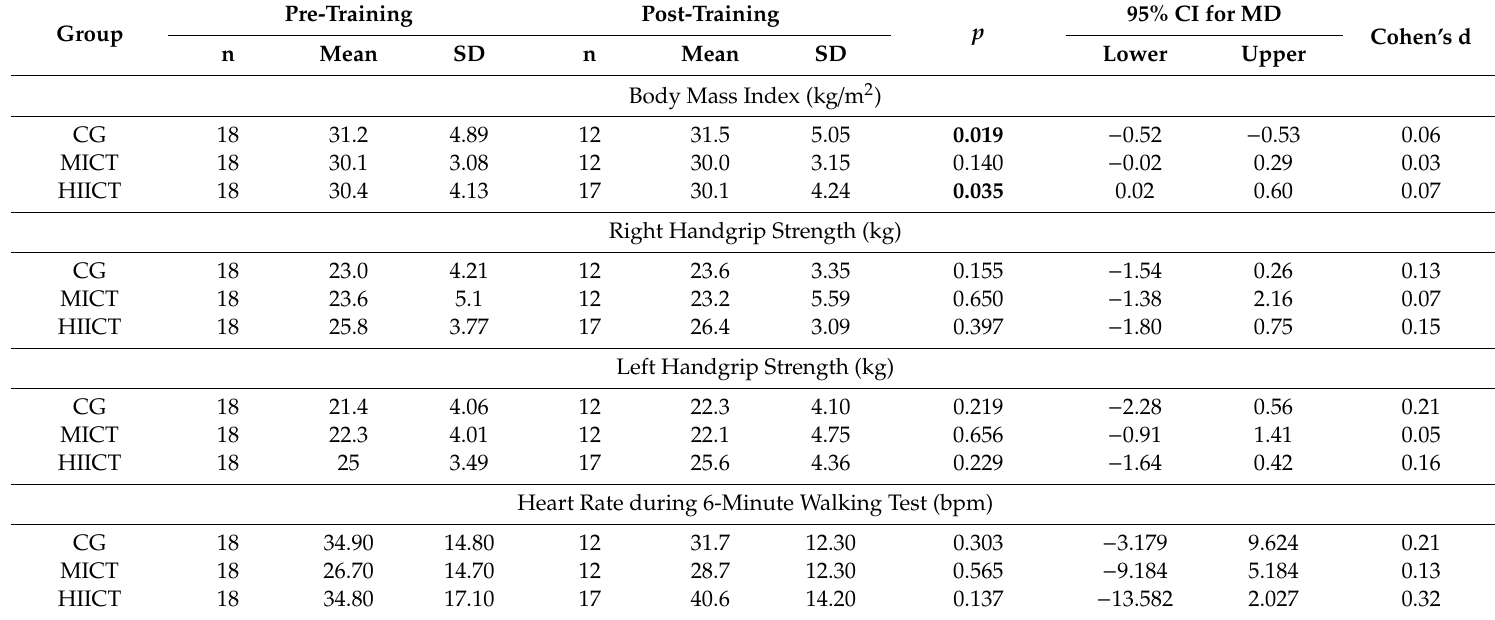
Table 7. Intra-group di ff erences for the secondary outcomes on HIICT, MICT and